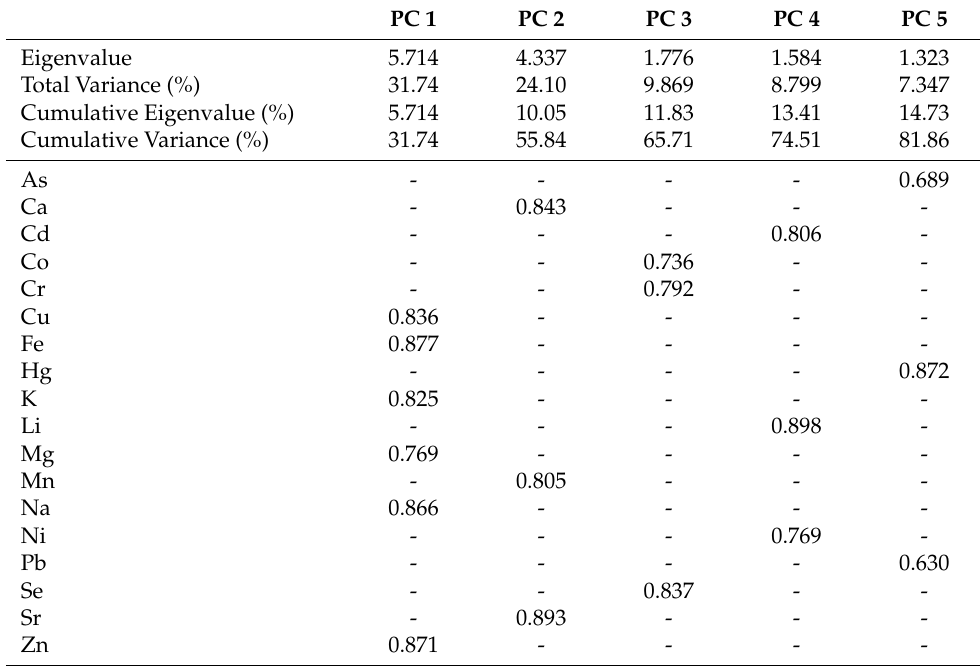
Table 4. Principle component analysis of selected metals in Catla catla